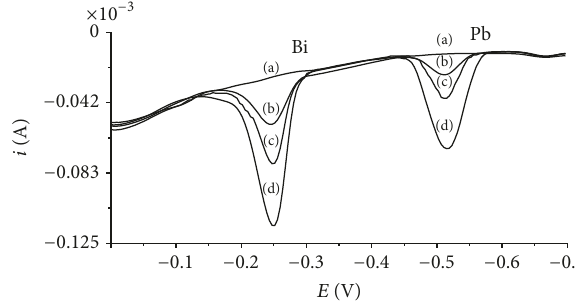
Figure 5: Differential pulse voltammograms obtained in the course of the Bi(III) and Pb(II) determination in Lake Zemborzyce water: (a) Lake Zemborzyce water diluted two times; (b) as (a) + 1 × 10 −8 mol L −1 Bi(III) and Pb(II); (c) as (a) + 2 × 10 −8 molL −1 Bi(III) and Pb(II); (d) as (a) + 4 × 10 −8 molL −1 Bi(III) and Pb(II). Concen- tration of cupferron 1 × 10 −4 mol L −1 and acetate buffer 0.1molL −1 (pH = 4.5). Accumulation potential − 0.05 V and accumulation time 30